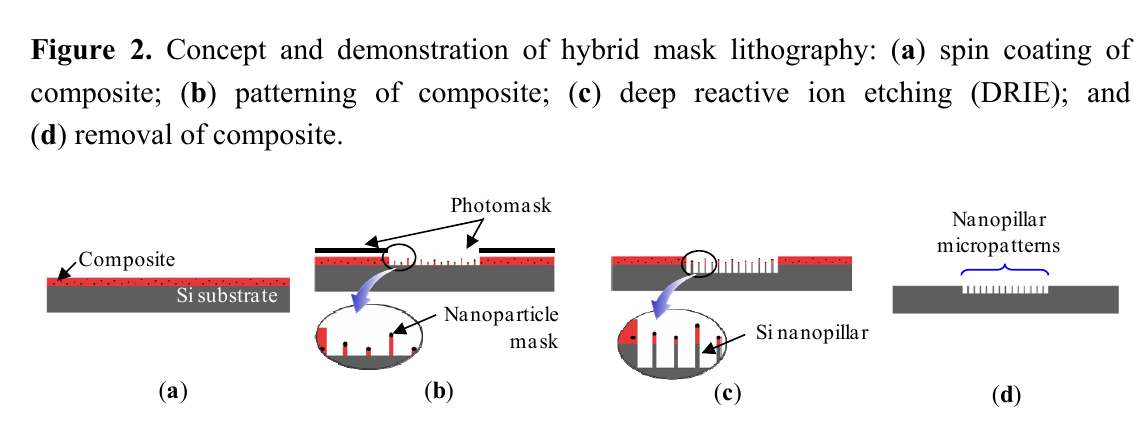
Figure 3. SEM images of fabricated structure by hybrid mask lithography: ( a ) perspective view; and ( b ) cross-sectional image of fabricated nanopillar